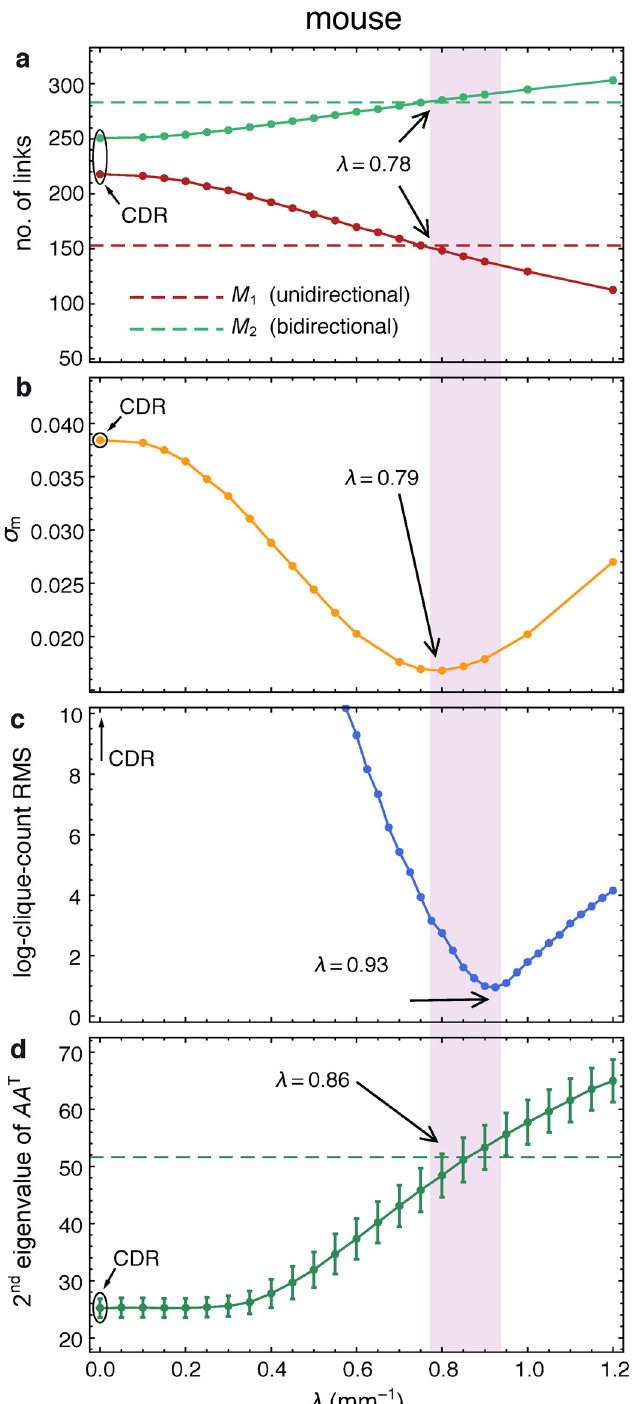
Fig 3. Consistency of fit by the EDR mouse model. (a – d) Determining λ by matching graph properties between the model and experimental data; data points show the average of 1,000 model-generated networks; vertical purple band: range of best fit for λ . Dashed lines in a and d indicate experimental data; (a) M M 1 and 2 represent counts of uni- and bidirectional links, respectively; (b) Root mean square (RMS) of log- ratios of 3-motif counts; (c) Root mean square of log-ratios of clique counts. (d) Second eigenvalue of AA T , where A is the adjacency matrix (using the co-occurrence matrix AA T , as it is a symmetric matrix and therefore has real eigenvalues).